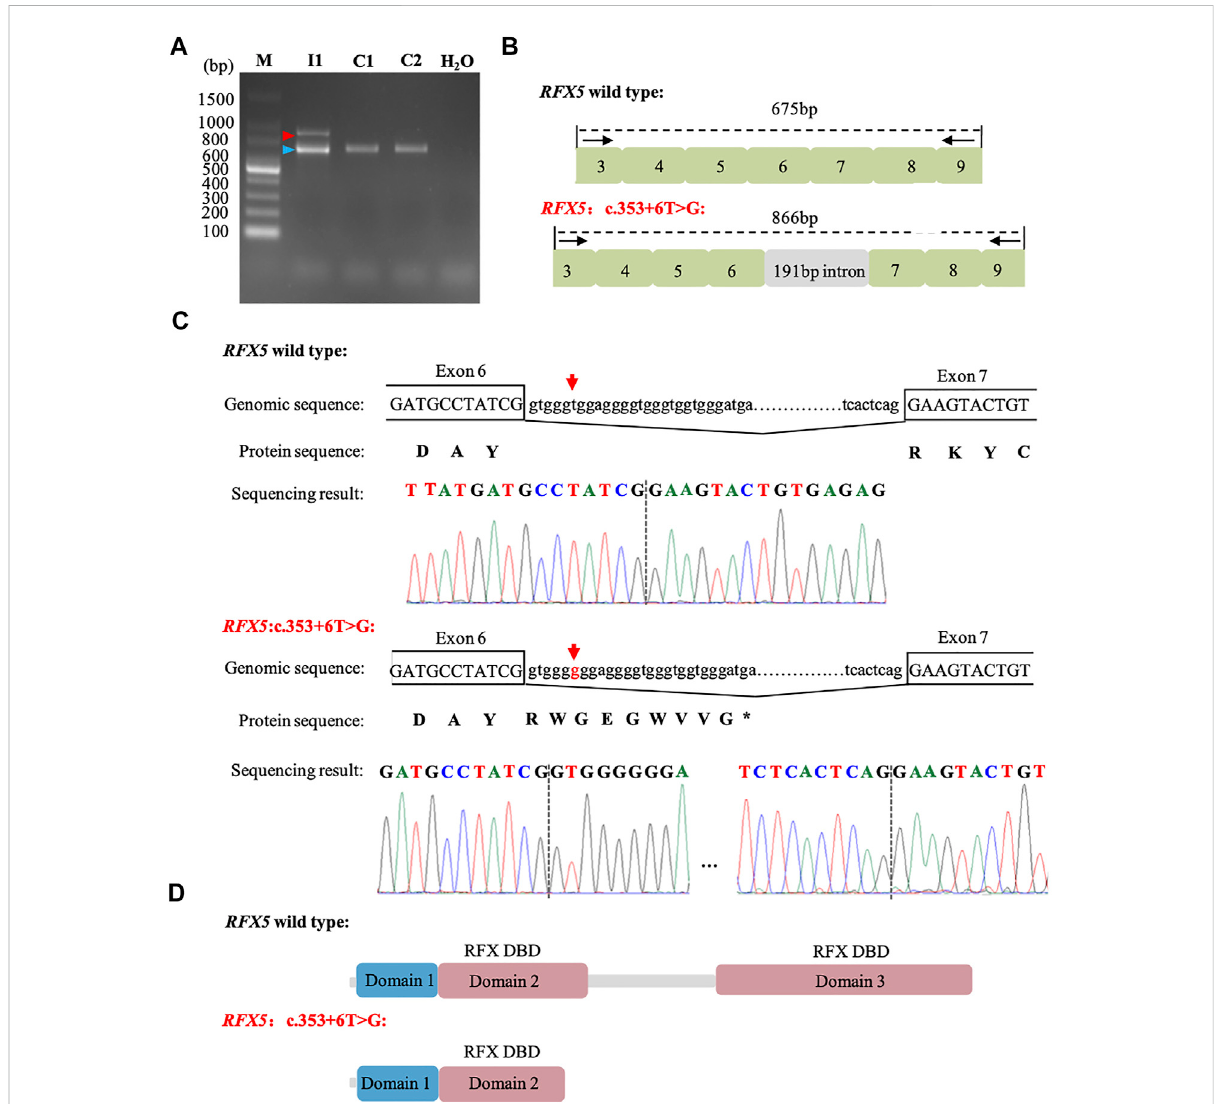
FIGURE 2 Analysis of c. 353 + 6T > G splicing mutation in RFX5 . (A) : RT-PCR analysis of RFX5 cDNA from peripheral blood samples. Agarose gel (1.5%) electrophoresisofRT-PCRproductsgeneratedfromI 1 (mother),C1andC2(normalcontrols).AmpliconsresultingfromaberrantlysplicedmRNAand normal spliced mRNA are marked by red and blue arrowheads, respectively. (B) : Schematic representation of exon three to nine and intron six organization in RFX5. (C) : Sequence analysis of the RT-PCR products from the mother. The arrows indicate the position of the c. 353 + 6T > G mutation. (D) : The structure with domains of wild-type and c. 353 + 6T > G splicing mutation RFX5 protein. Wild-type RFX5 protein consists of three domains, amongwhichdomain twoand domain three aretheimportantDBDswhile thesplicing mutation leads to theprematureoftheprotein and signi fi cantly damages the protein